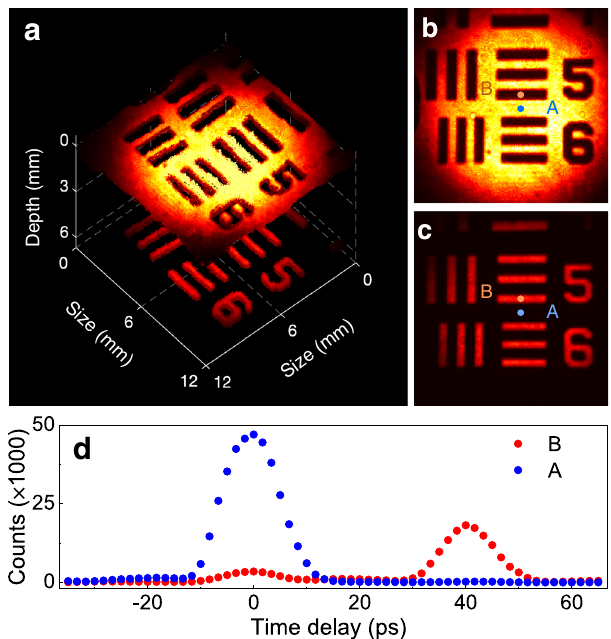
Fig. 7 Proof-of-principle illustration of three-dimensional MIR upconversion imaging. a Reconstructed 3D image for a resolution test target stacked on a silver mirror. The substrate of the negative target is coated with the chrome, only leaving the pattern itself clear. The transmitted light through the pattern is then re fl ected by the the silver mirror. The time-resolving ability of the implemented upconversion imaging system enables to differentiate the images from the front and back re fl ective surfaces, as shown in b and c , respectively. d presents the intensity evolutions for the two pixels labelled as A and B when varying the temporal delay of the pump gating pulse. The dynamic process is recorded in Supplementary Movie